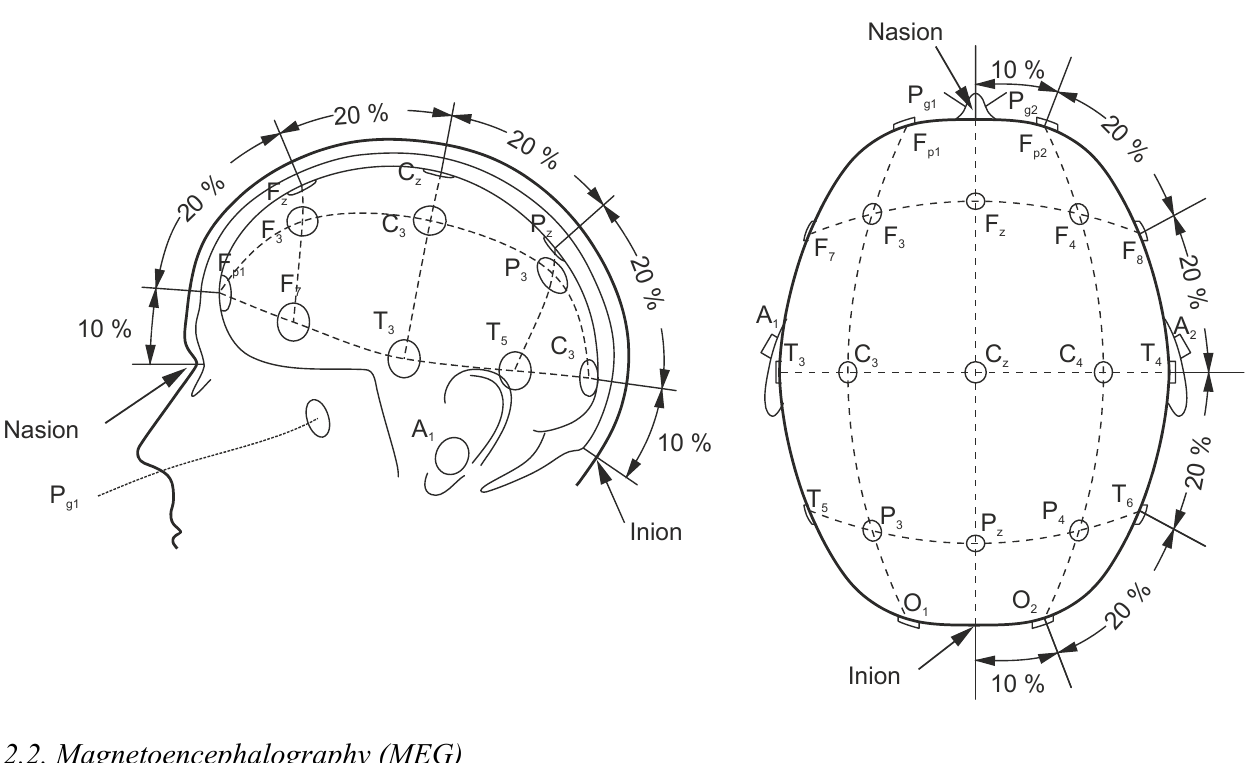
Figure 1. Electrode placement over